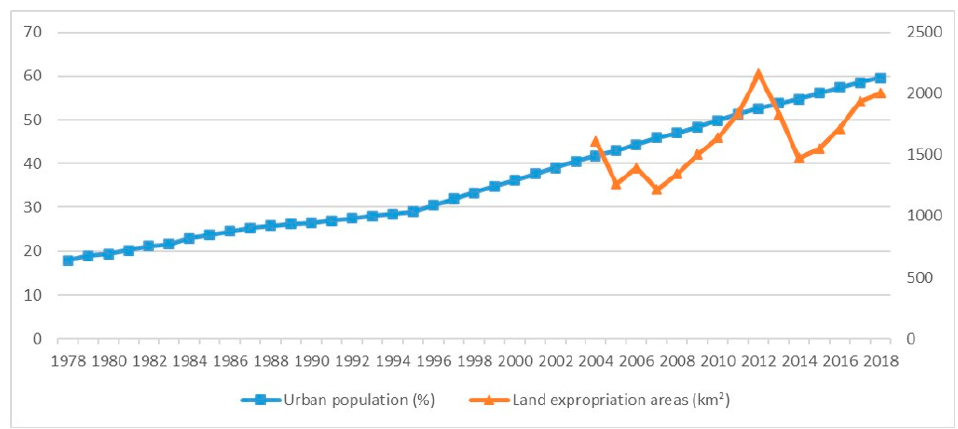
Figure 1. Change of urban population proportion and land expropriation areas in China (1978–2018). Data source: National Bureau of Statistics of China. The data of land expropriation areas from 1978 to 2003 are not available. Urbanisation and land development blend intimately interweave in China’s socioeco- nomic transition in the post-reform era. On the one hand, “land urbanisation” has been well